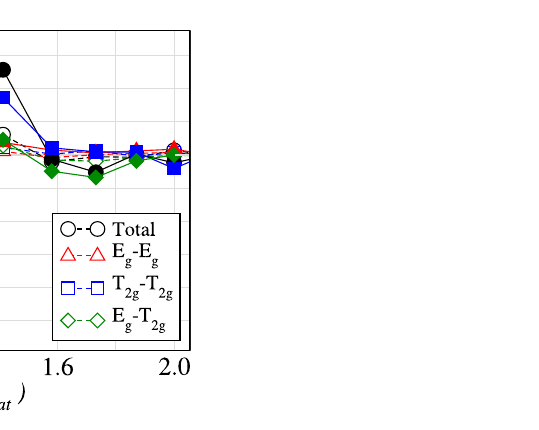
Figure 4. Projected density of states for the LS (top panel) and HS (bottom panel) states in fcc Fe. The results were obtained considering the experimental lattice constant of Fe in a Cu matrix ( a lat = 5.82 a.u.).